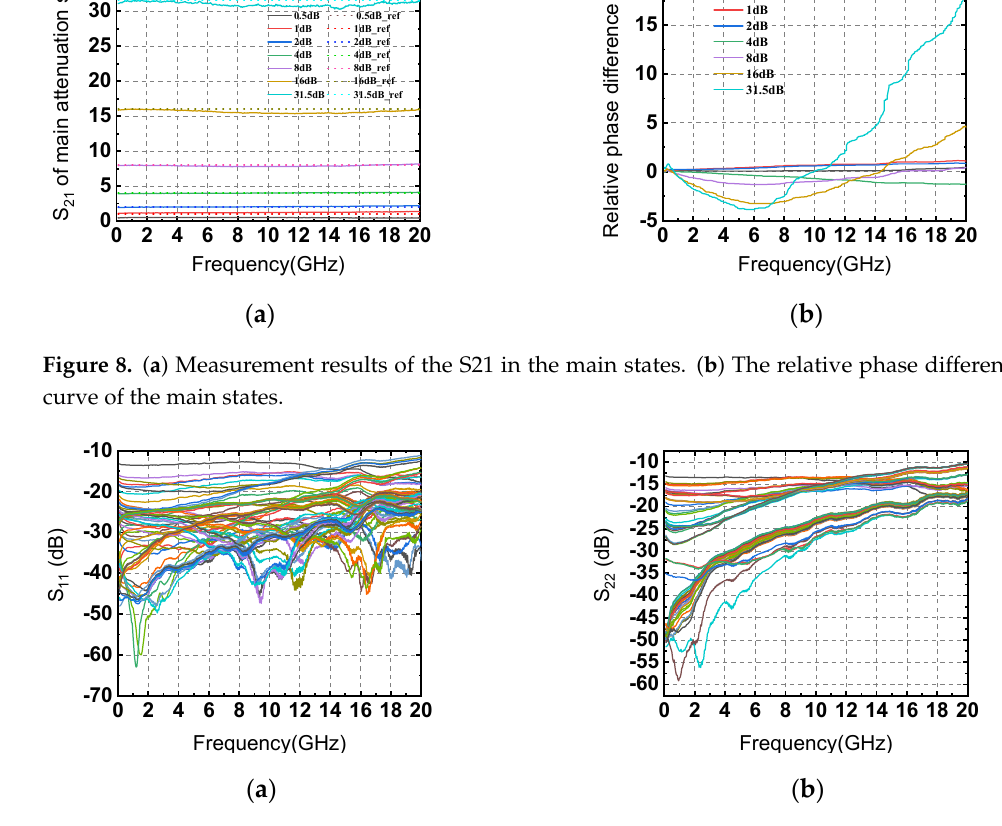
Figure 9. ( a ) Measurement results of the S11 and ( b ) S22.